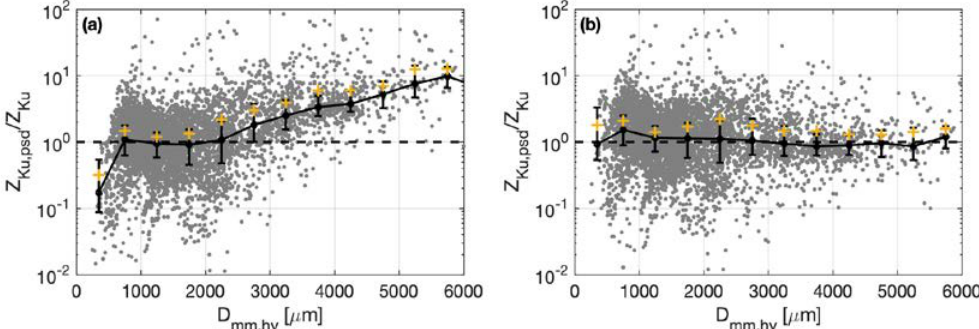
Figure 4. Ratios of radar reflectivity derived from PSD ( Z Ku , psd ) to the bulk measured Ku-band reflectivity ( Z Ku ) using ( a ) HY04 m–D relation and ( b ) best estimate of ( a , b ) that minimizes χ 2 in each D mm , hy bins. The black solid lines and error bars represent median values, 25% and 75% percentiles of Z Ku , psd / Z Ku in each D mm , hy bins. Yellow plus signs are the mean values for each D mm , hy bins. Black dashed lines denote the 1:1 line.